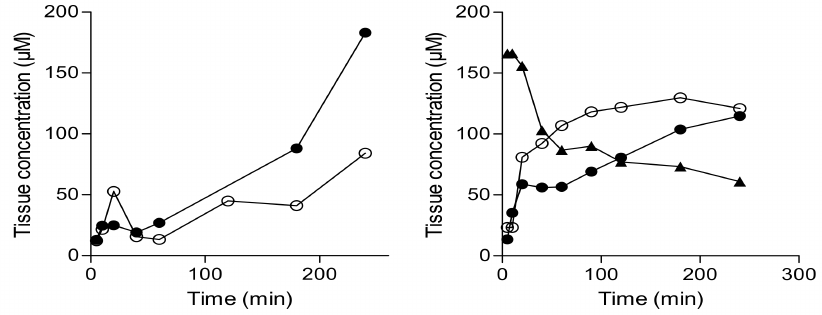
Figure 6. The metabolic stability of the L -dopa–lazabemide prodrug in rat brain ( left ) and liver ( right ) homogenates. Key: lazabemide (open circles); L -dopa (filled circles); prodrug (triangles). Values are given as mean ( µ M) ± standard deviation of triplicate